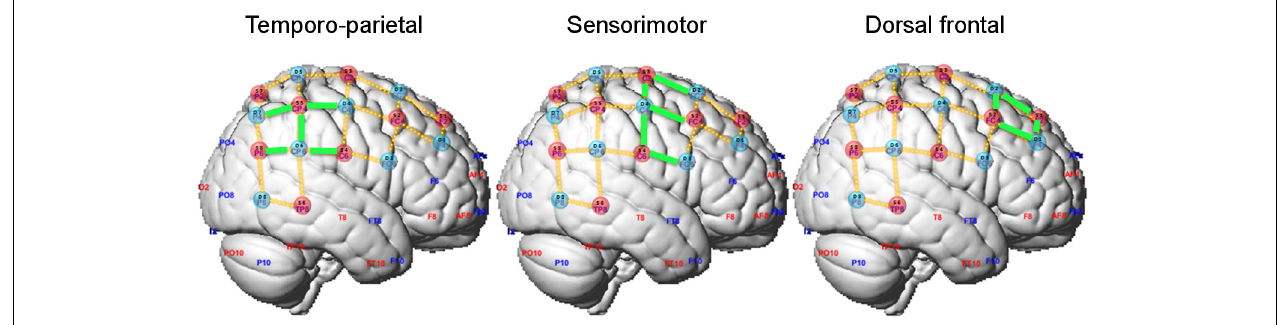
FIGURE 2 | Optode layout and definition of regions of interest (ROIs). Selected channels in each ROI are marked in green.